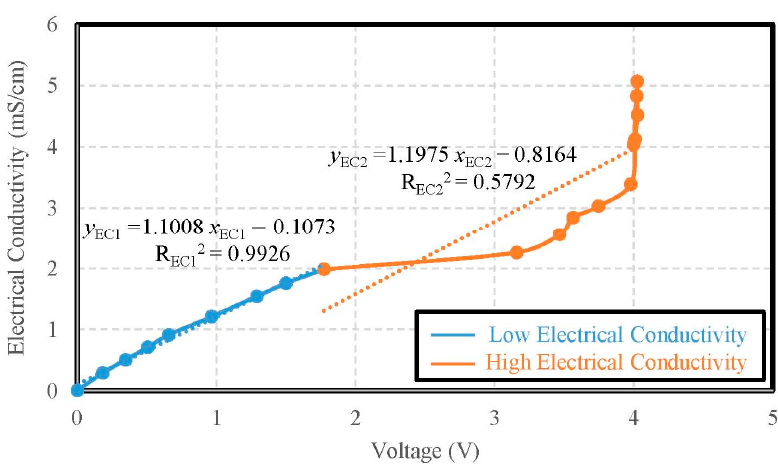
Figure 11. The calibration curve of electric conductivity.